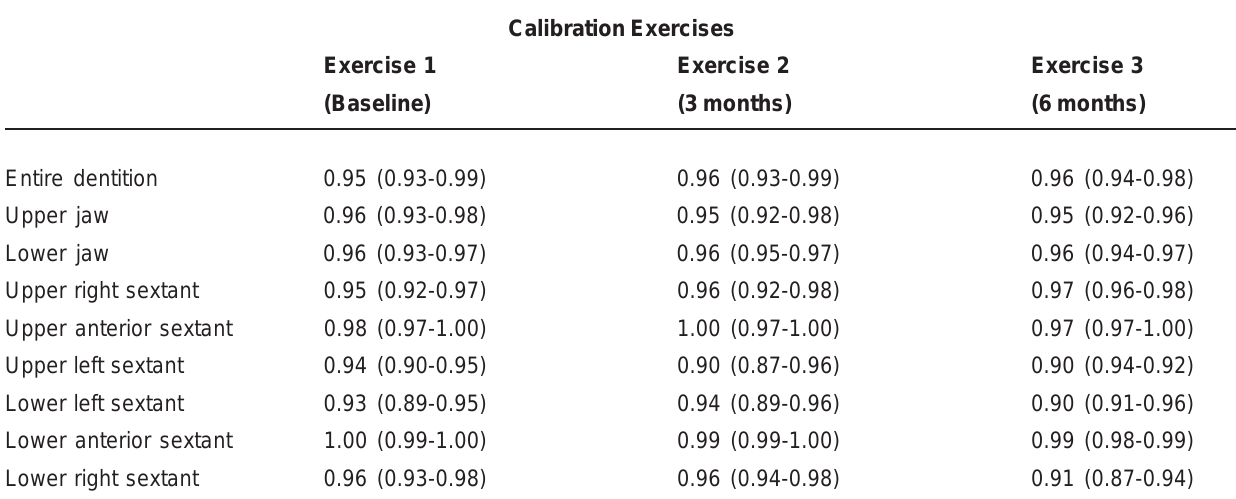
TABLE 1- Mean Kappa values for interexaminer reliability (interval of variation) under the WHO caries diagnosis threshold, considering the entire dentition, jaws and sextants according to calibration exercises. Piracicaba,